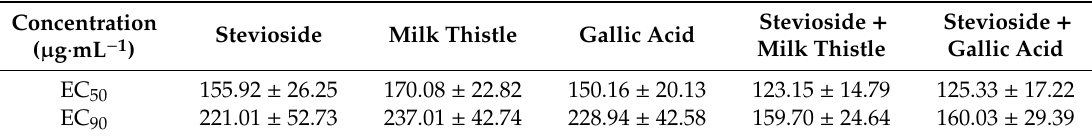
Table 1. Effective concentrations that inhibited mycelial growth by 50% and 90% (EC 50 and EC 90 , respectively).